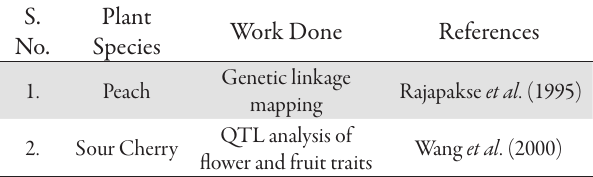
Tab. 2. Successful examples of RFLP techniques in fruit crops S.